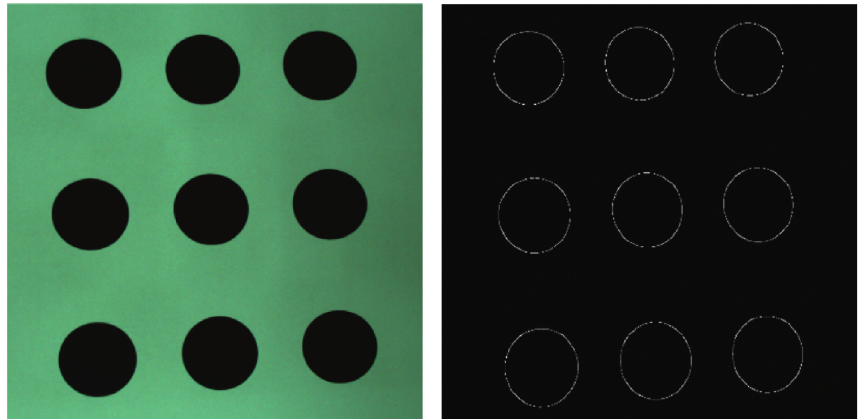
Figure 16: (a) Scattered point cloud data. (b) Boundary point.